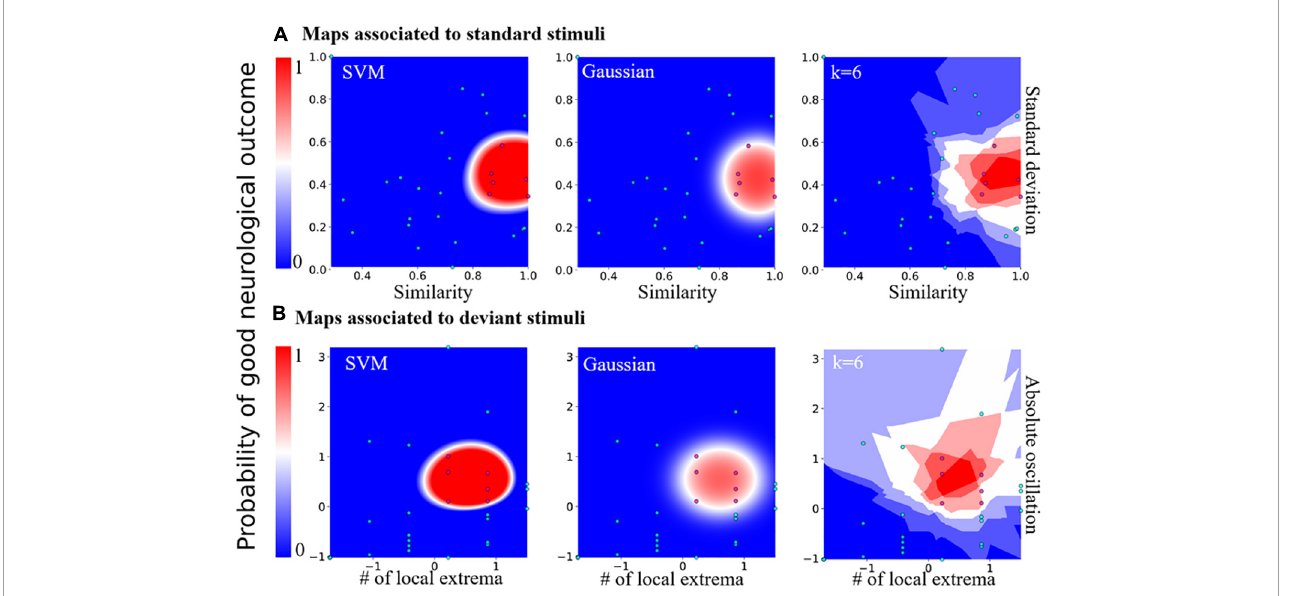
FIGURE4 Predictive probability maps of good neurological outcome. (A) Probability maps computed from features of the standard stimuli responses. From left to right: maps computed from SVM, Gaussian, and the k-nearest neighbors classifier ( k = 6, the worst case scenario). (B) Probability maps computed from features of the deviant stimuli features. From left to right: maps computed from SVM, Gaussian, and the k-nearest neighbors classifier with distance-related weights, k = 6 for